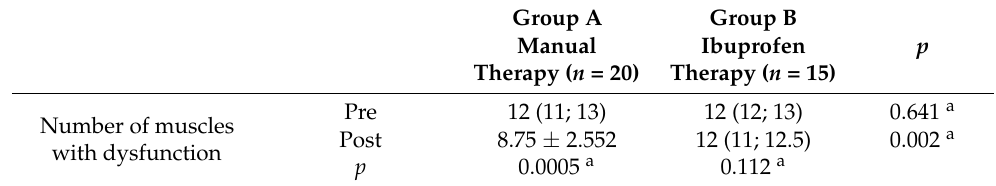
Table 8. Number of muscles with dysfunction pre and post manual or ibuprofen treatment.